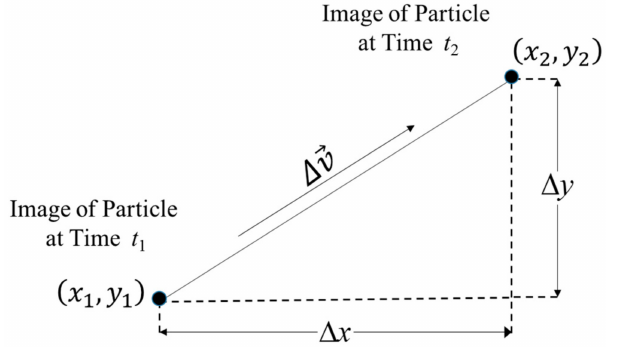
Figure 5. PIV principle of